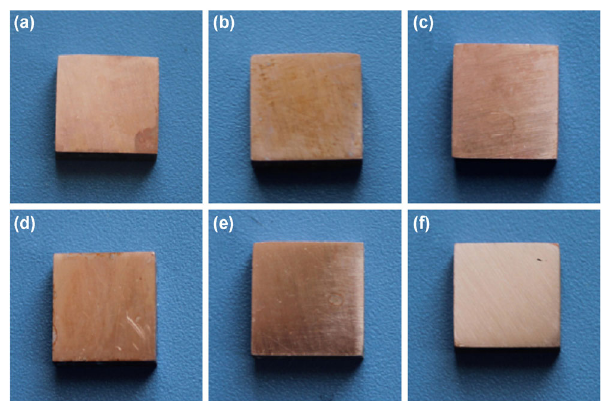
Fig. 3 Photographs of the copper strips after immersion in (a) [Ch][Gly]; (b) [Ch][Ala]; (c) [Ch][Ser]; (d) [Ch][Ile]; (e) [Ch][Phe]. (f) is the photograph of the copper strip before the corrosion test.